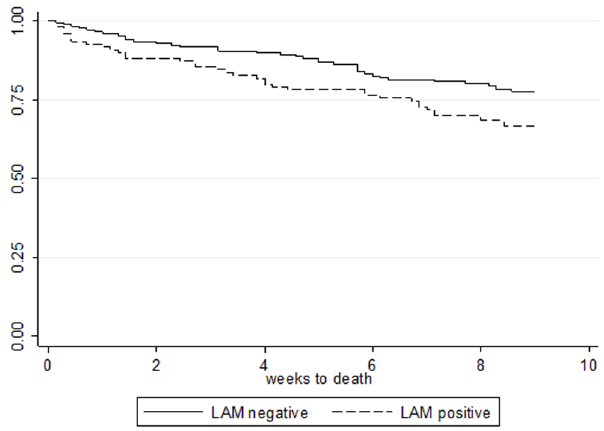
Figure 3. Kaplan-Meier survival curves of LAM negative patients (solid line), and LAM positive patients (dashed line). Participants who could not be traced at 2 months were considered lost to follow-up on the day after